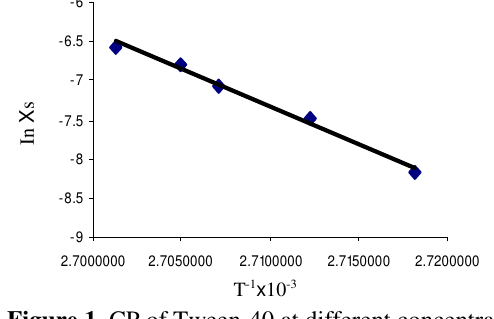
Figure 1. CP of Tween-40 at different concentration